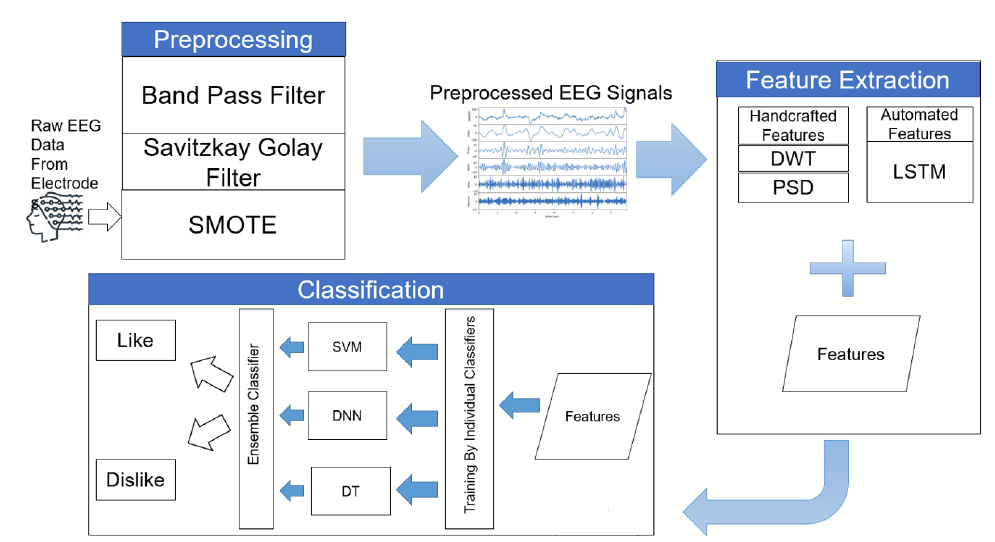
Figure 4. Flow diagram of the proposed consumer emotion